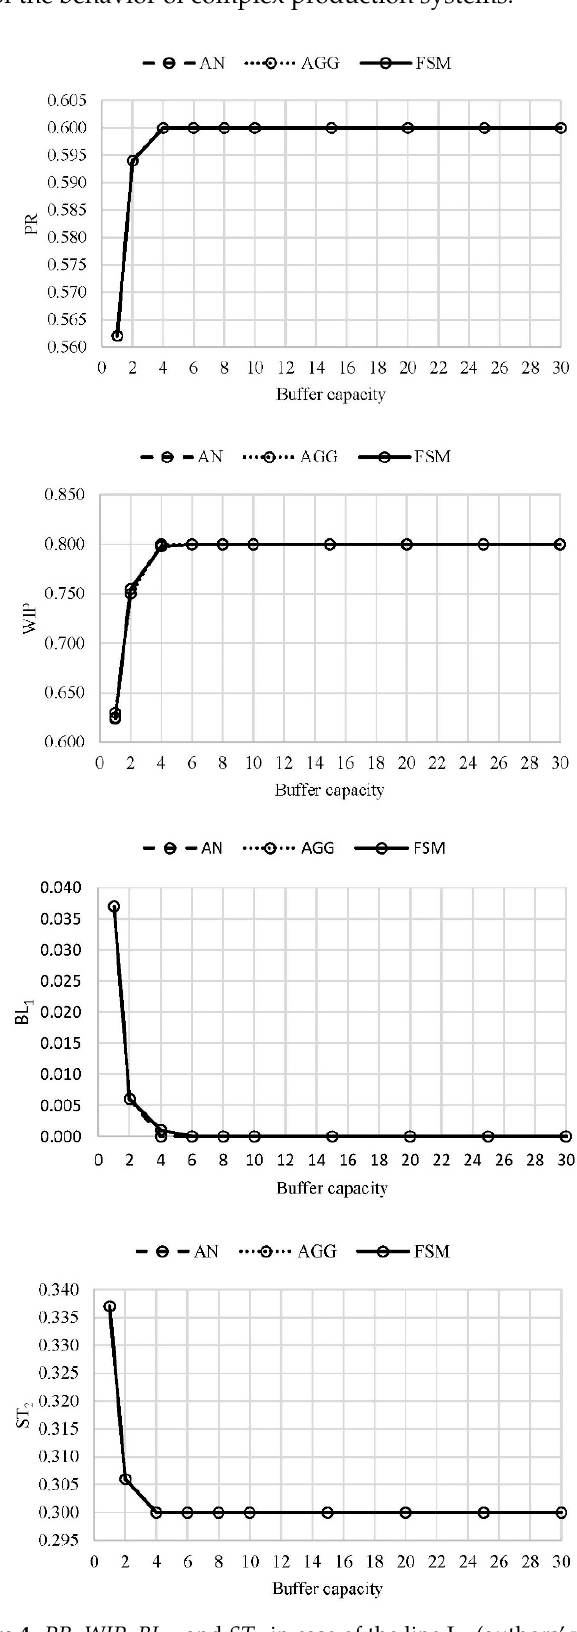
Figure 4. PR , WIP , BL 1 , and ST 2 in case of the line L 1 (authors’